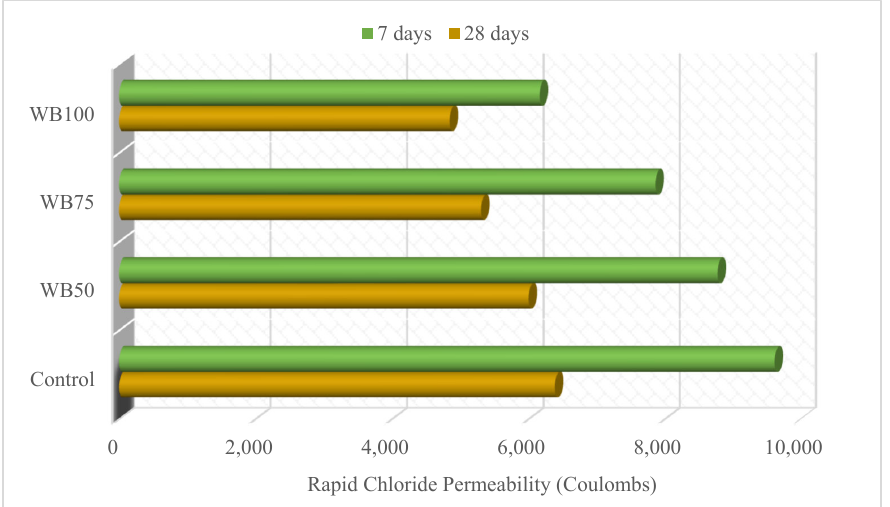
Figure 7. Rapid chloride permeability of mixtures.